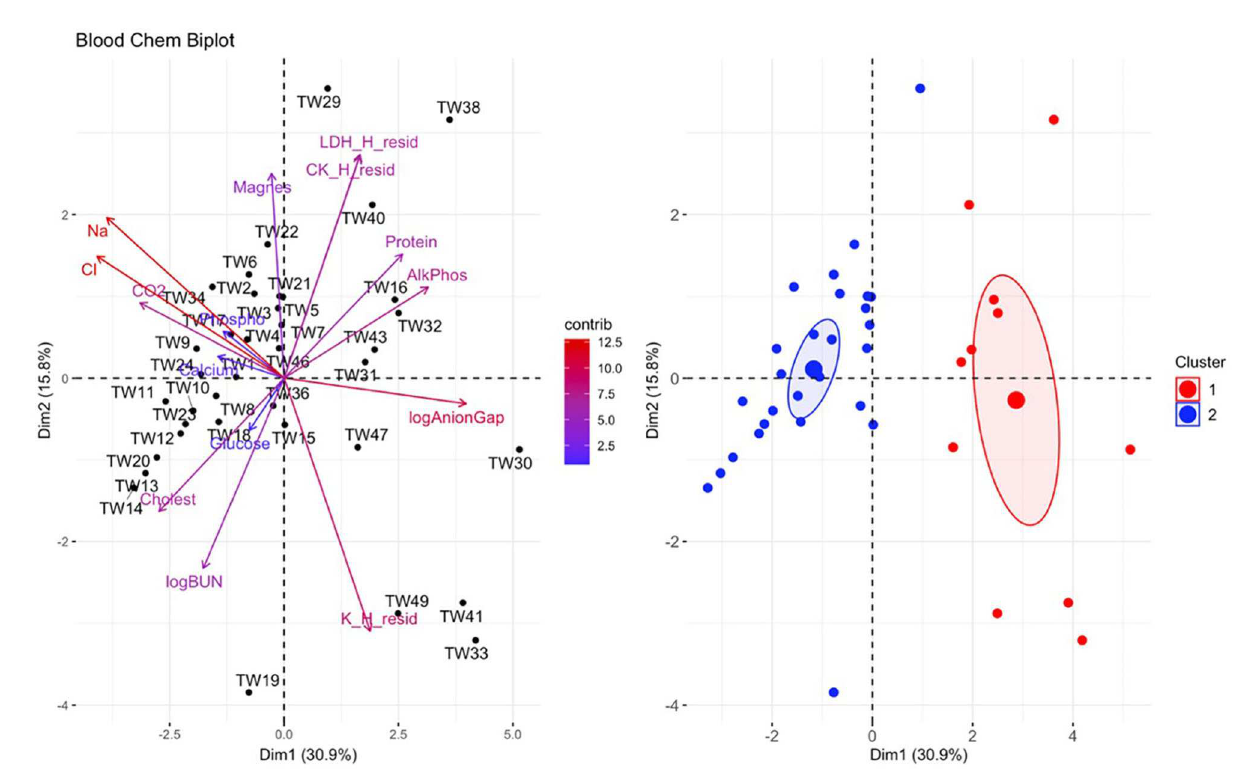
FIGURE4 Principal component analysis (PCA) for biochemical data. In the biplot on the left, individuals in the same space as the arrowhead had higher values of the blood parameter, and individuals in the opposite direction had lower levels of the blood parameter. The length and color of each arrow represent the strength of the relationship. The plot on the right is showing how the individuals clustered together using K means clustering. The majority of Taricha granulosa in cluster 1 (red) were Batrachochytrium salamandrivorans ( Bsal ) infected, clinically diseased individuals, and the majority of T. granulosa in cluster 2 (blue) were controls or Bsal -infected, non-clinically diseased individuals. Na, Sodium; Cl, Chloride; cholest, Cholesterol; logBUN, Blood urea nitrogen; Phospho, Phosphorous; AlkPhos, Alkaline phosphatase; Magnes, Magnesium; K_H_resid, the residuals of potassium (K) regressed on hemolytic index (H); K_H_resid, the residuals of creatinine (CK) regressed on H; K_H_resid, the residuals of lactate dehydrogenase (LDH) regressed on